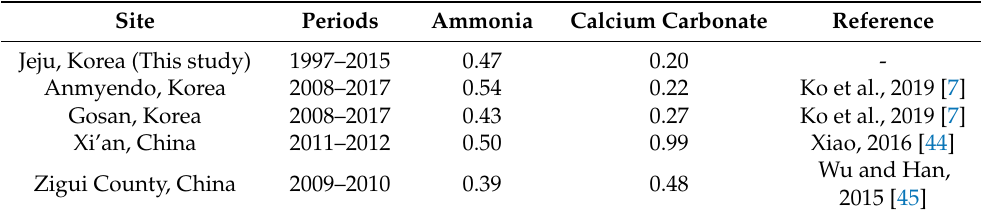
Table 6. Neutralization factors (NF) by ammonia and calcium carbonate.